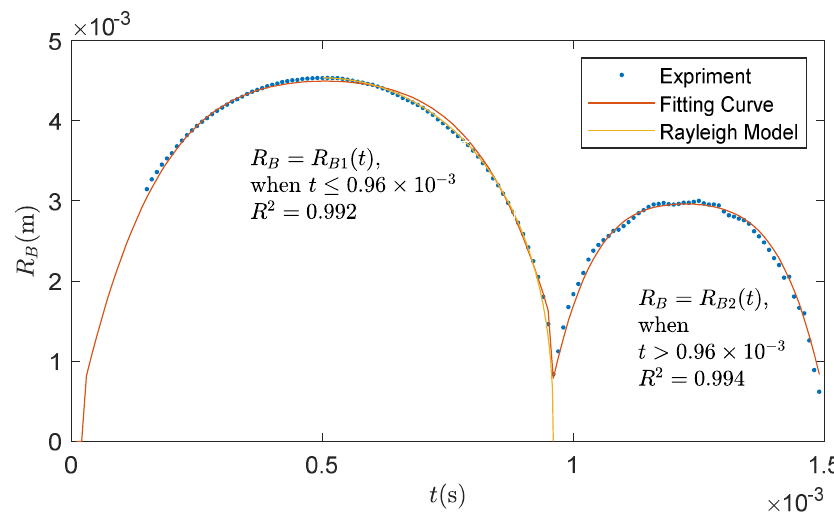
Figure 6. Radius time history of the cavitation bubble in the first two cycles.